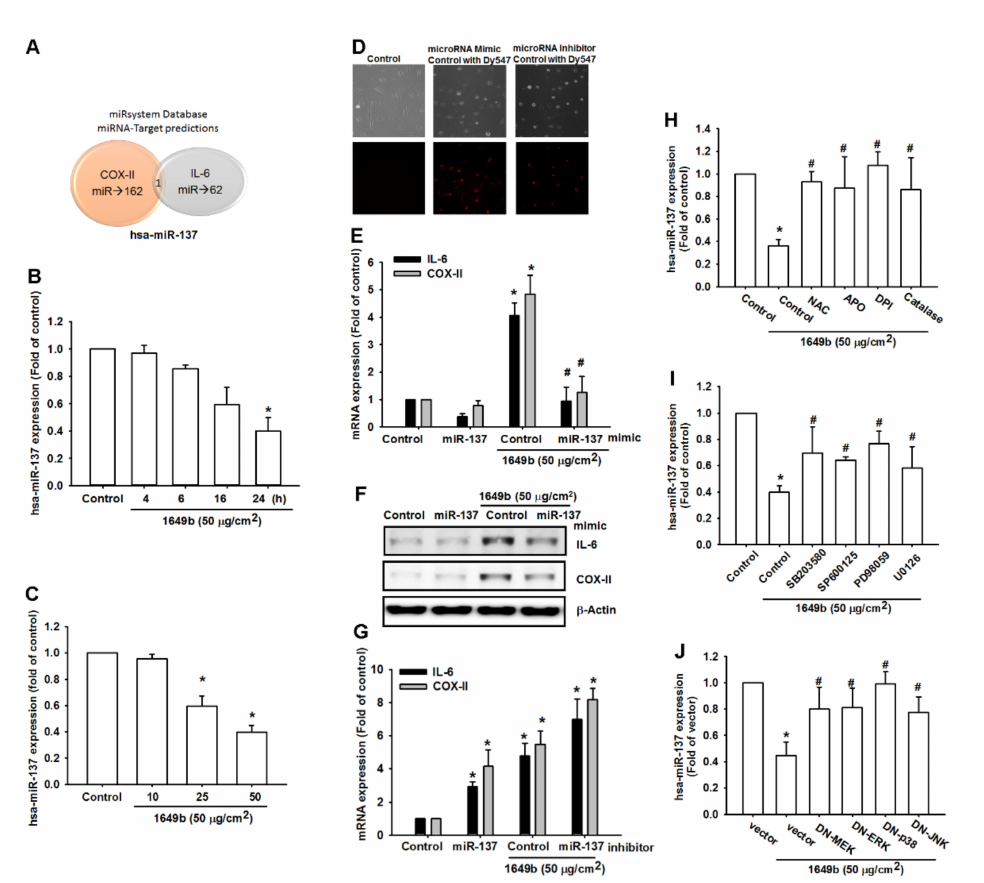
Figure 4. hsa-miR-137 inhibition is involved in PM-induced IL-6 and COX-2 expression. ( A ) Searches of the online computational algorithms (miRsystem) and miRNA-Target predictions for candidate miRNAs that target the IL-6 and COX-II-regions revealed the involvement of hsa-miR-137; ( B , C ) RA patient’s synovial fibroblast cells were incubated with various concentrations of PMs for 24 h or with PM2.5 (50 µ g / cm 2 ) for 4, 6, 16 or 24 h; hsa-miR-137 expression was assessed by qPCR; ( D ) Cells were transfected with fluorescent dye-labeled miRNA mimic control and miRNA inhibitor for 24 h, the fluorescence staining was examined by; ( E – G ) RASFs were transfected with hsa-miR-137 mimics or hsa-miR-137 inhibitors for 24 h, followed by stimulation with PMs for 24 h; IL-6 and COX-II-expression was examined by qPCR and western blot; ( H – J ) Cells were pretreated for 30 min with NAC, DPI, catalase and APO or MAPK inhibitor or MEK, ERK, JNK and p38 MAPK mutants stimulated with PMs for 24 h. hsa-miR-137 expression was assessed by qPCR. Results are expressed as the mean ± SD. * p < 0.05 as compared with baseline. # p < 0.05 as compared with the PMs-treated